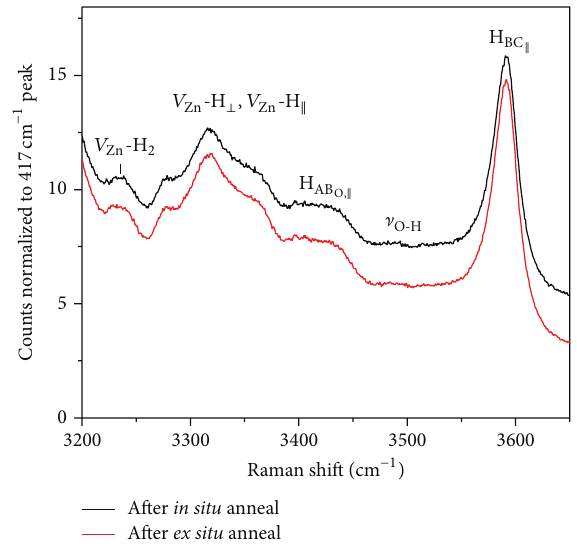
Figure 6: Raman spectra of a H-decorated native defects present after the in situ anneal (black) that are reduced after the ex situ 800 ∘ C O 2 anneal